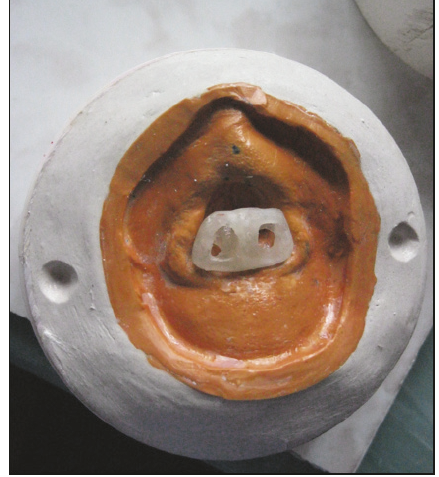
Figure 5: Acrylic resin substructure on dewaxed master cast.